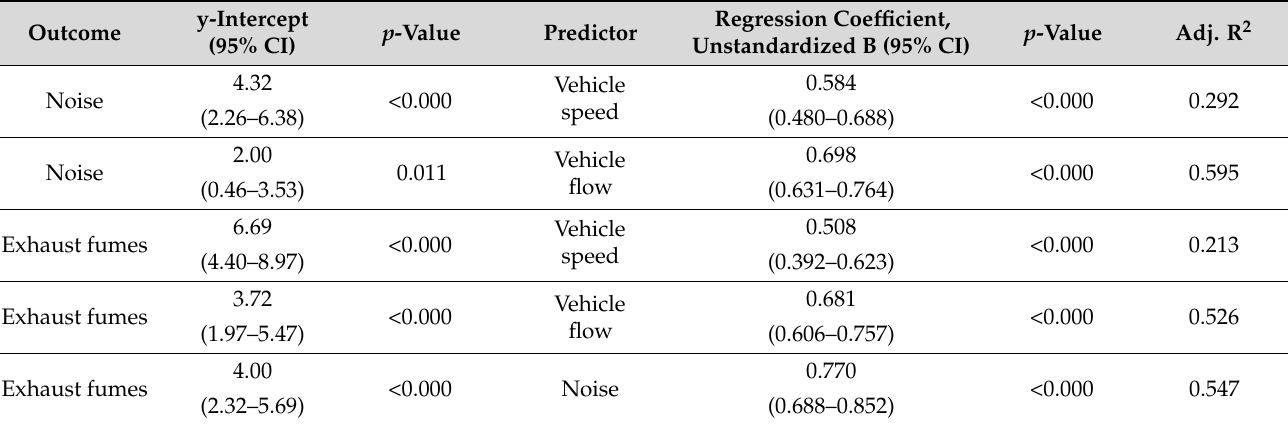
Table 5. Relations between the predictor